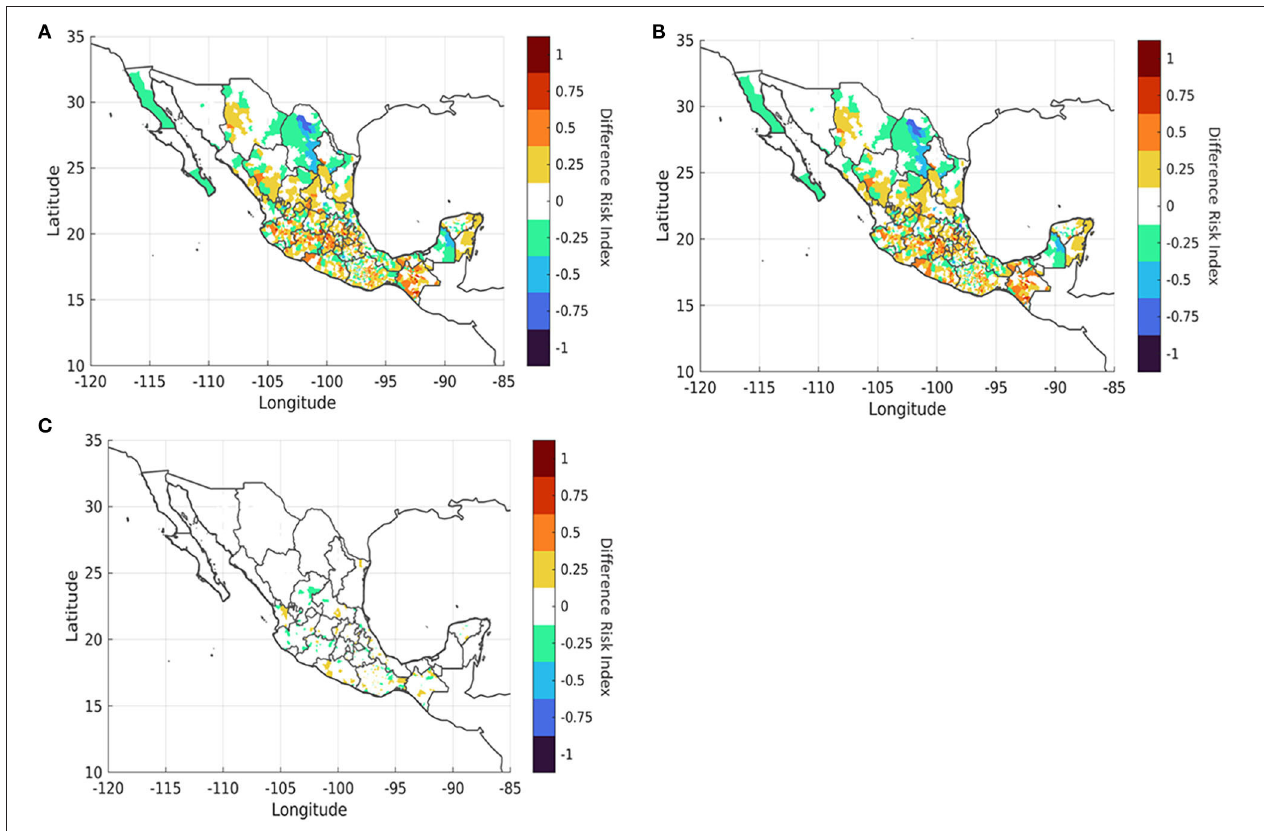
FIGURE 5 | (A) Difference between future Risk RCP8.5 scenario and the Historical Risk, (B) Difference between future Risk RCP8.5 + 25% scenario and the Historical Risk, (C) Difference between future Risk RCP8.5 and RCP8.5 + 25% scenarios.